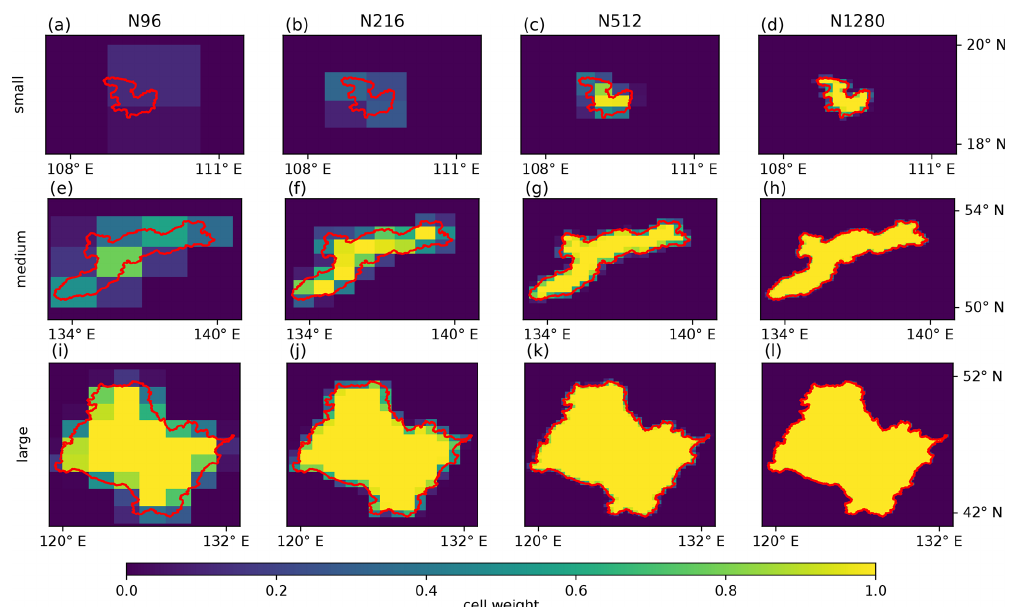
Figure 1. Weights used in the gridded representation of example basins at different resolutions. The basin with the median area from each of the basin scales in Table 2 is shown in each row, and each column shows the different simulation resolutions used in this study. The small, medium and large basins shown have areas of 5040, 54600 and 553000km 2